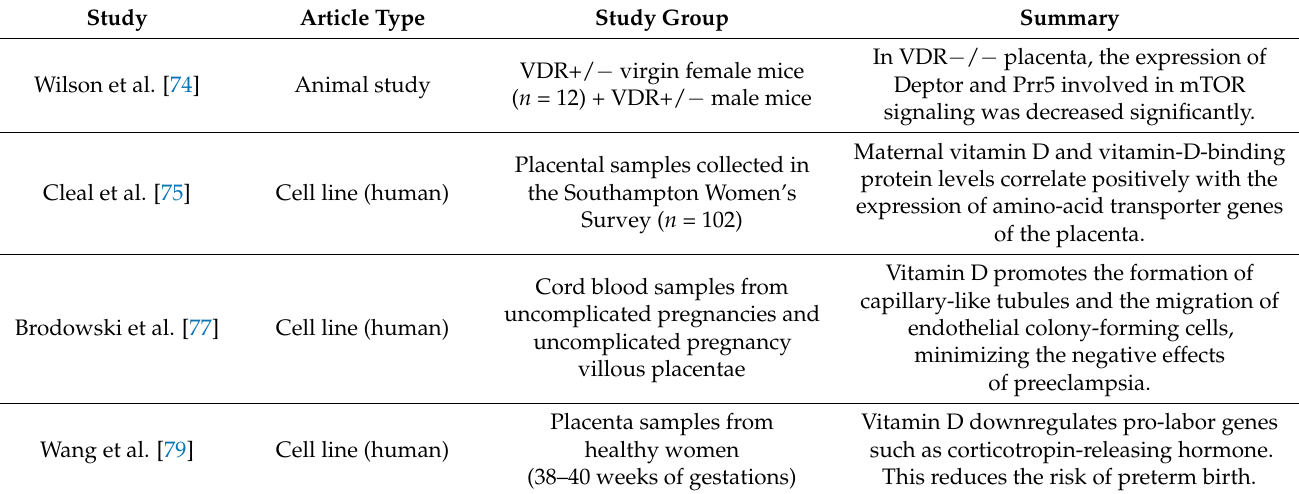
Table 3. Vitamin D deficiency and